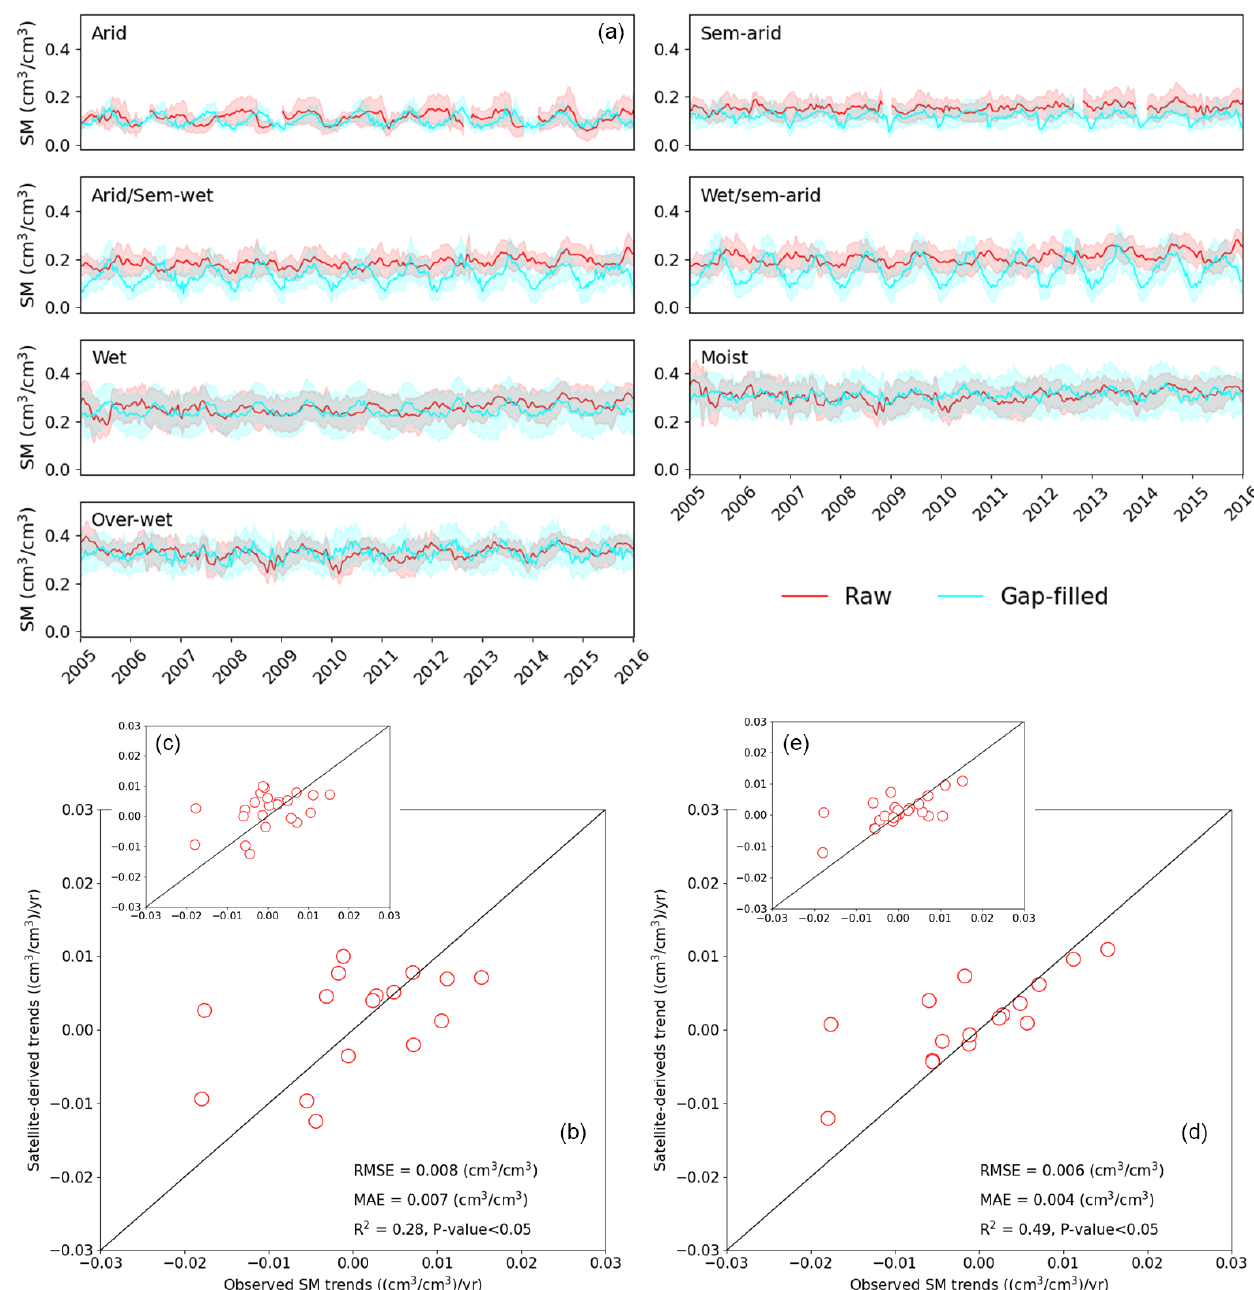
Figure 14. Panel (a) shows the temporal patterns of raw and gap-filled CCI SM regarding different climate regions during 2005–2015. The shaded area in panel (a) denotes ± 1 standard error. (b) and (c) : scatter plot of 1km CCI SM-derived trends against in situ measures during 2005–2014, and panel (b) shows the trends under the significance level, while panel (c) shows all the trends. (d) and (e) : scatter plot of 1km gap-filled SM-derived trends against in situ measures during 2005–2014, and panel (d) shows the trends under the significance level, while panel (e) shows all the